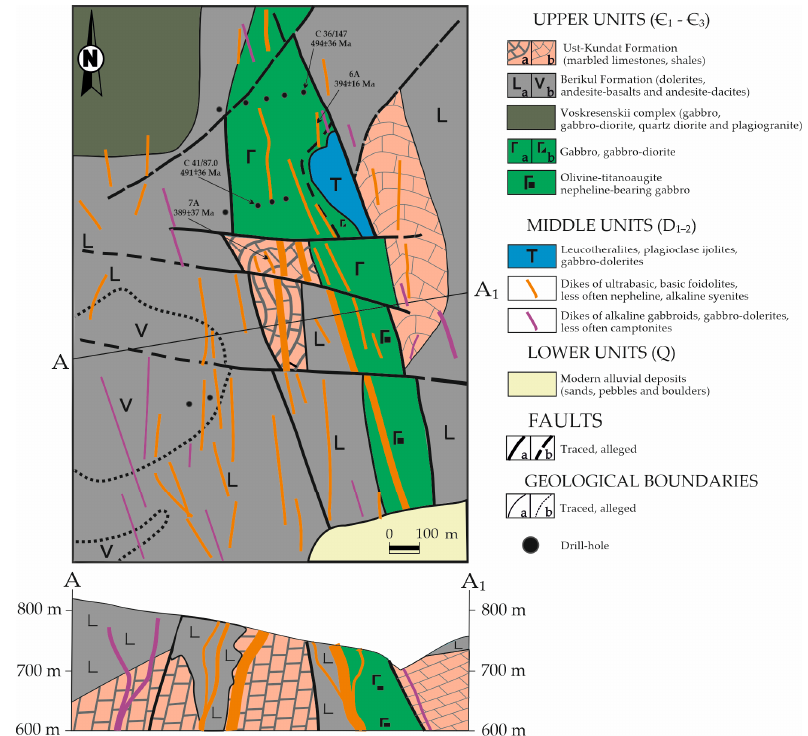
Figure 2. Simplified scheme of the geological structure and a section along the A-A 1 line of the University pluton on a scale of 1:5000 according to [54,55] with the additions by the authors. The center of the image is at about N55 ◦ 05 (cid:48) 30 (cid:48)(cid:48) , E88 ◦ 23 (cid:48) 30 (cid:48)(cid:48)